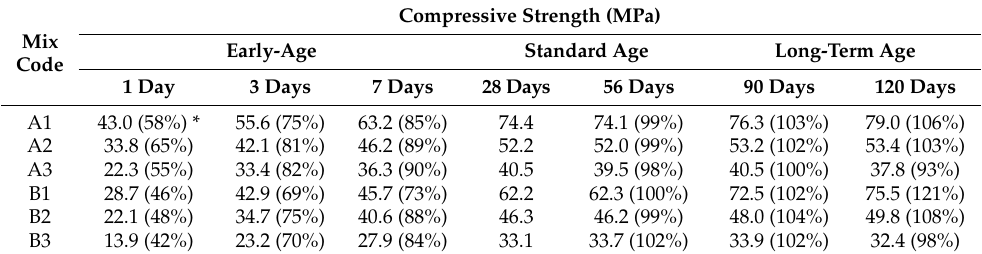
Table 5. Compressive strength development of concrete mixes.